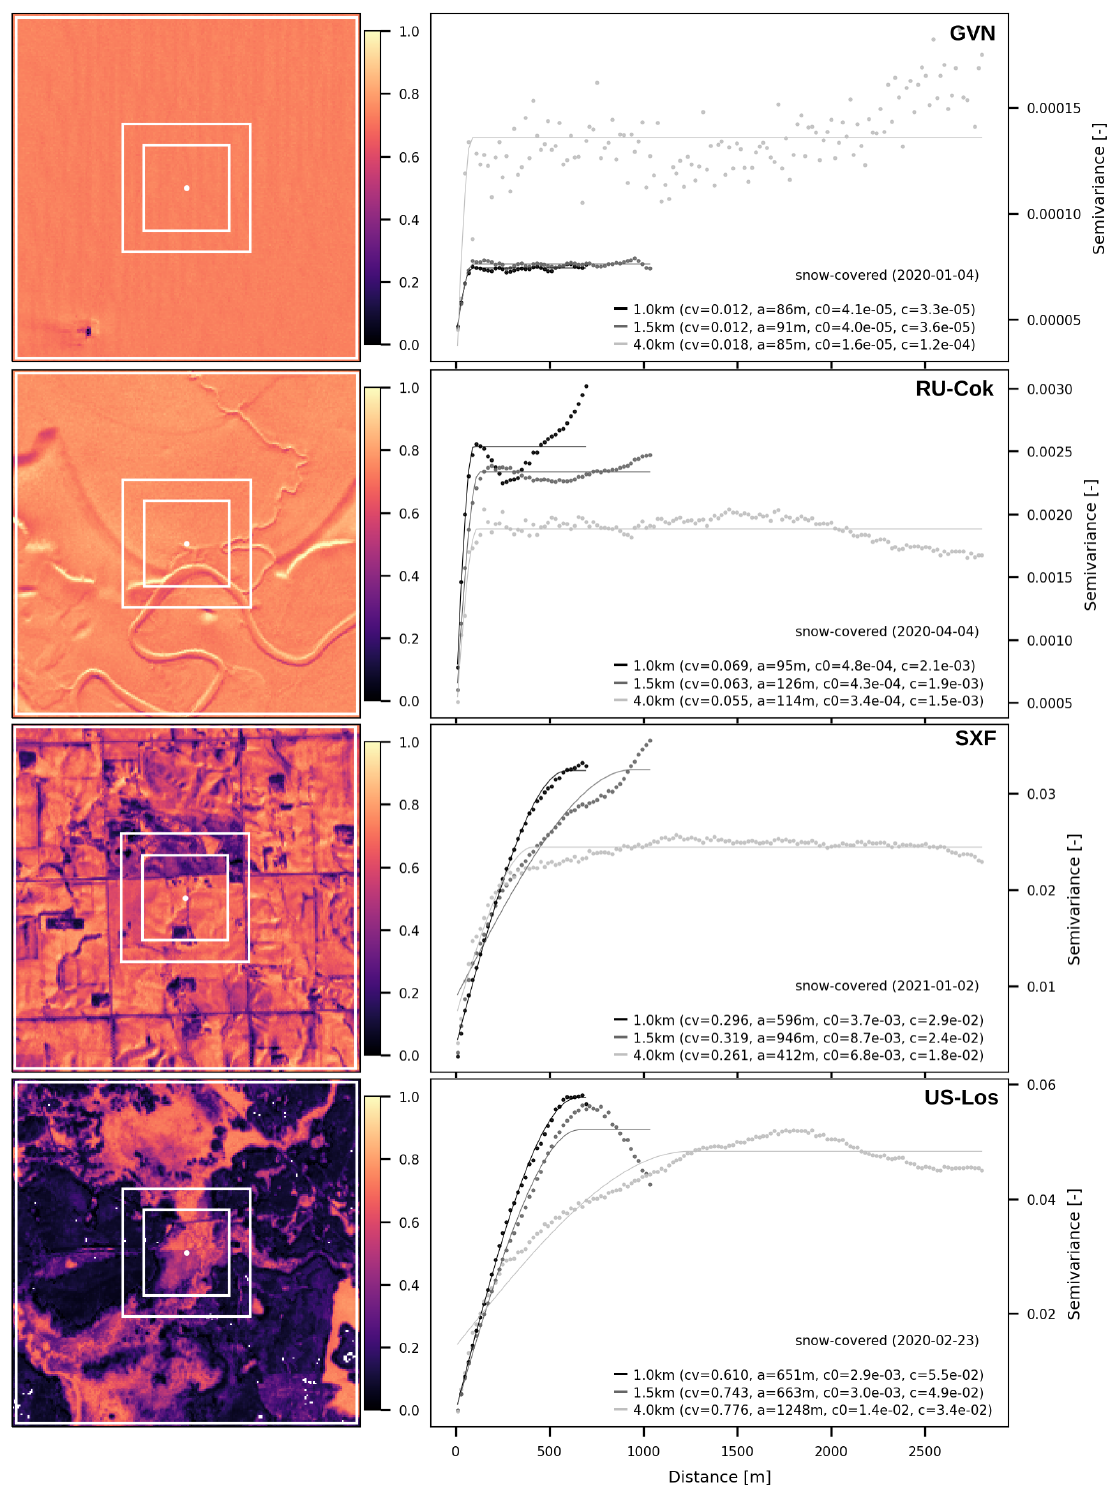
Figure 2. Variogram estimator (dots) and spherical models (lines) derived from S2 MSI L2A shortwave reflectance [-] (20 × 20 m) within 4 × 4 km, 1.5 × 1.5 km and 1 × 1 km regions around GVN, RU-CoK, SXF and US-LOS. CV = coefficient of variation, a = range, c 0 = nugget, c = partial